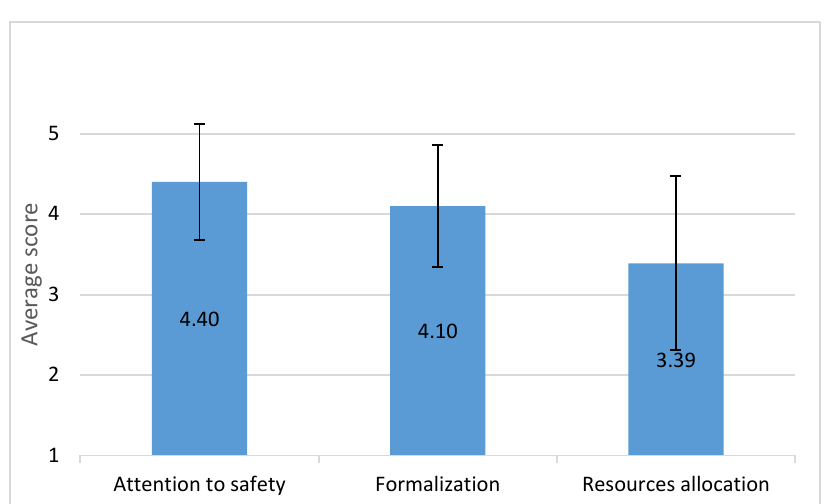
Figure 2. BARS averages with error bars (SD).